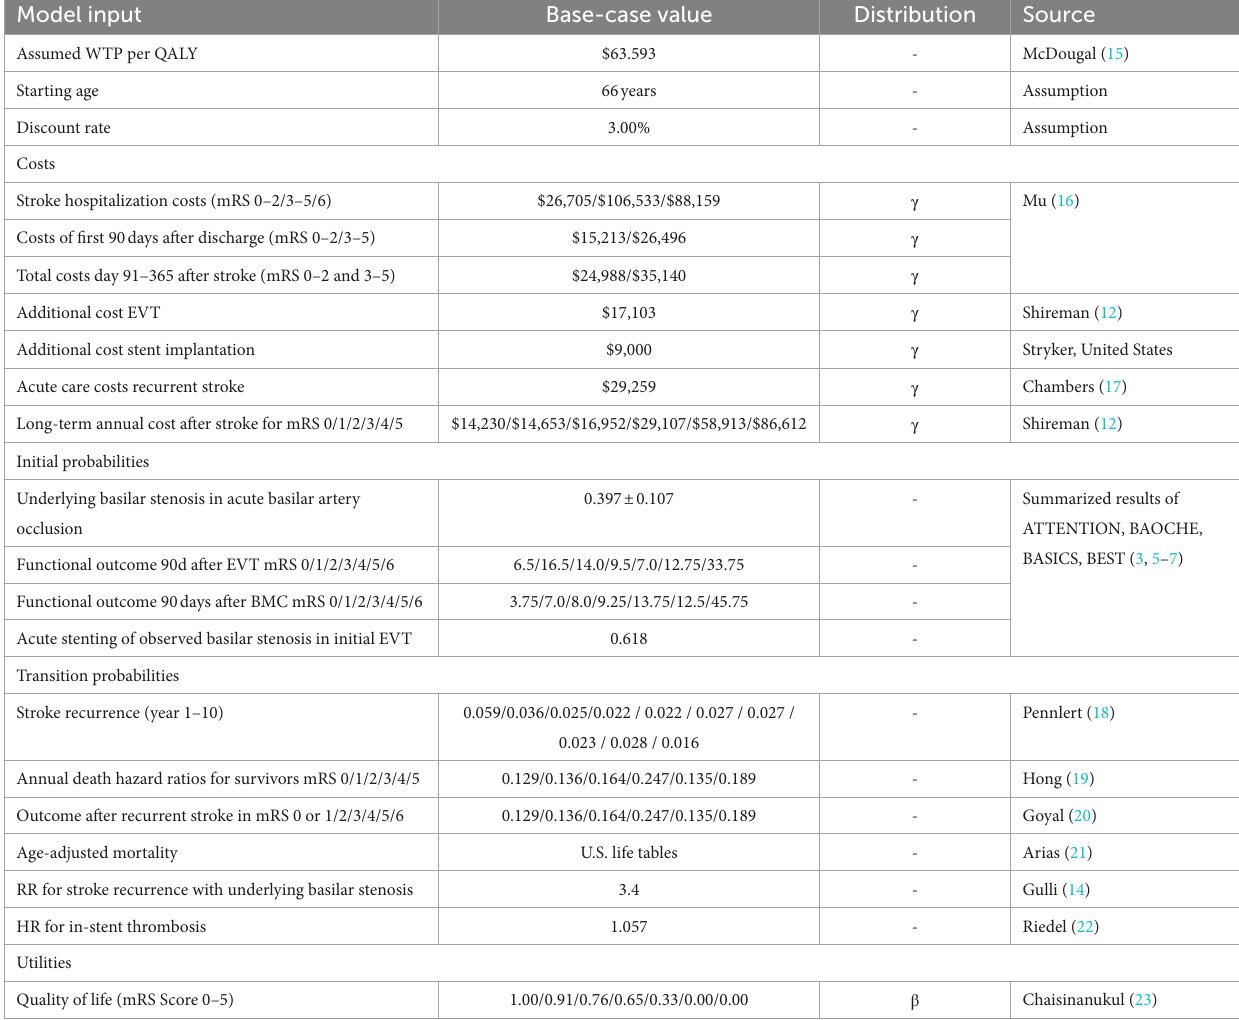
TABLE 2 Model input